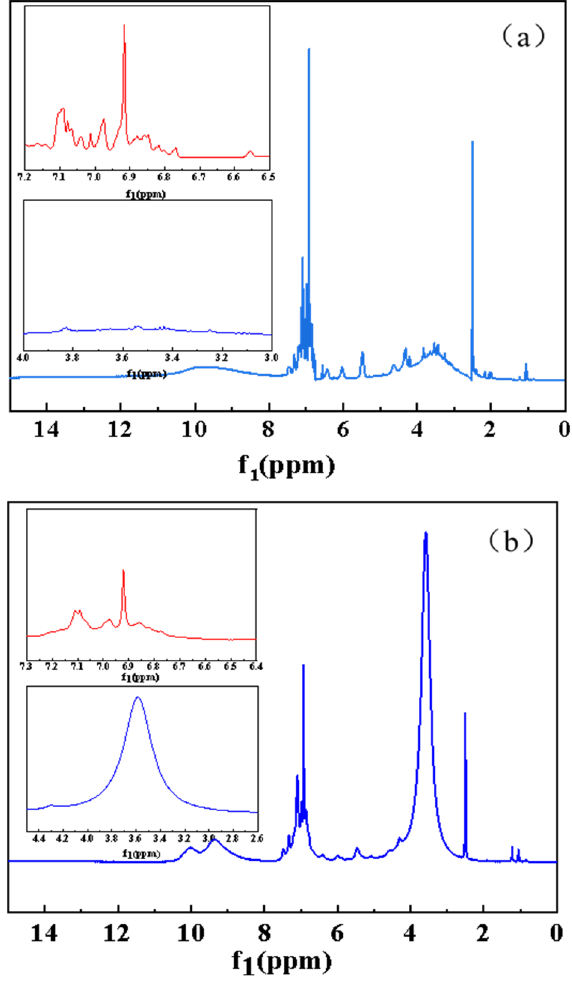
Figure 11. 1 H liquid NMR spectra of tannins and germanium–tannins ( a , b